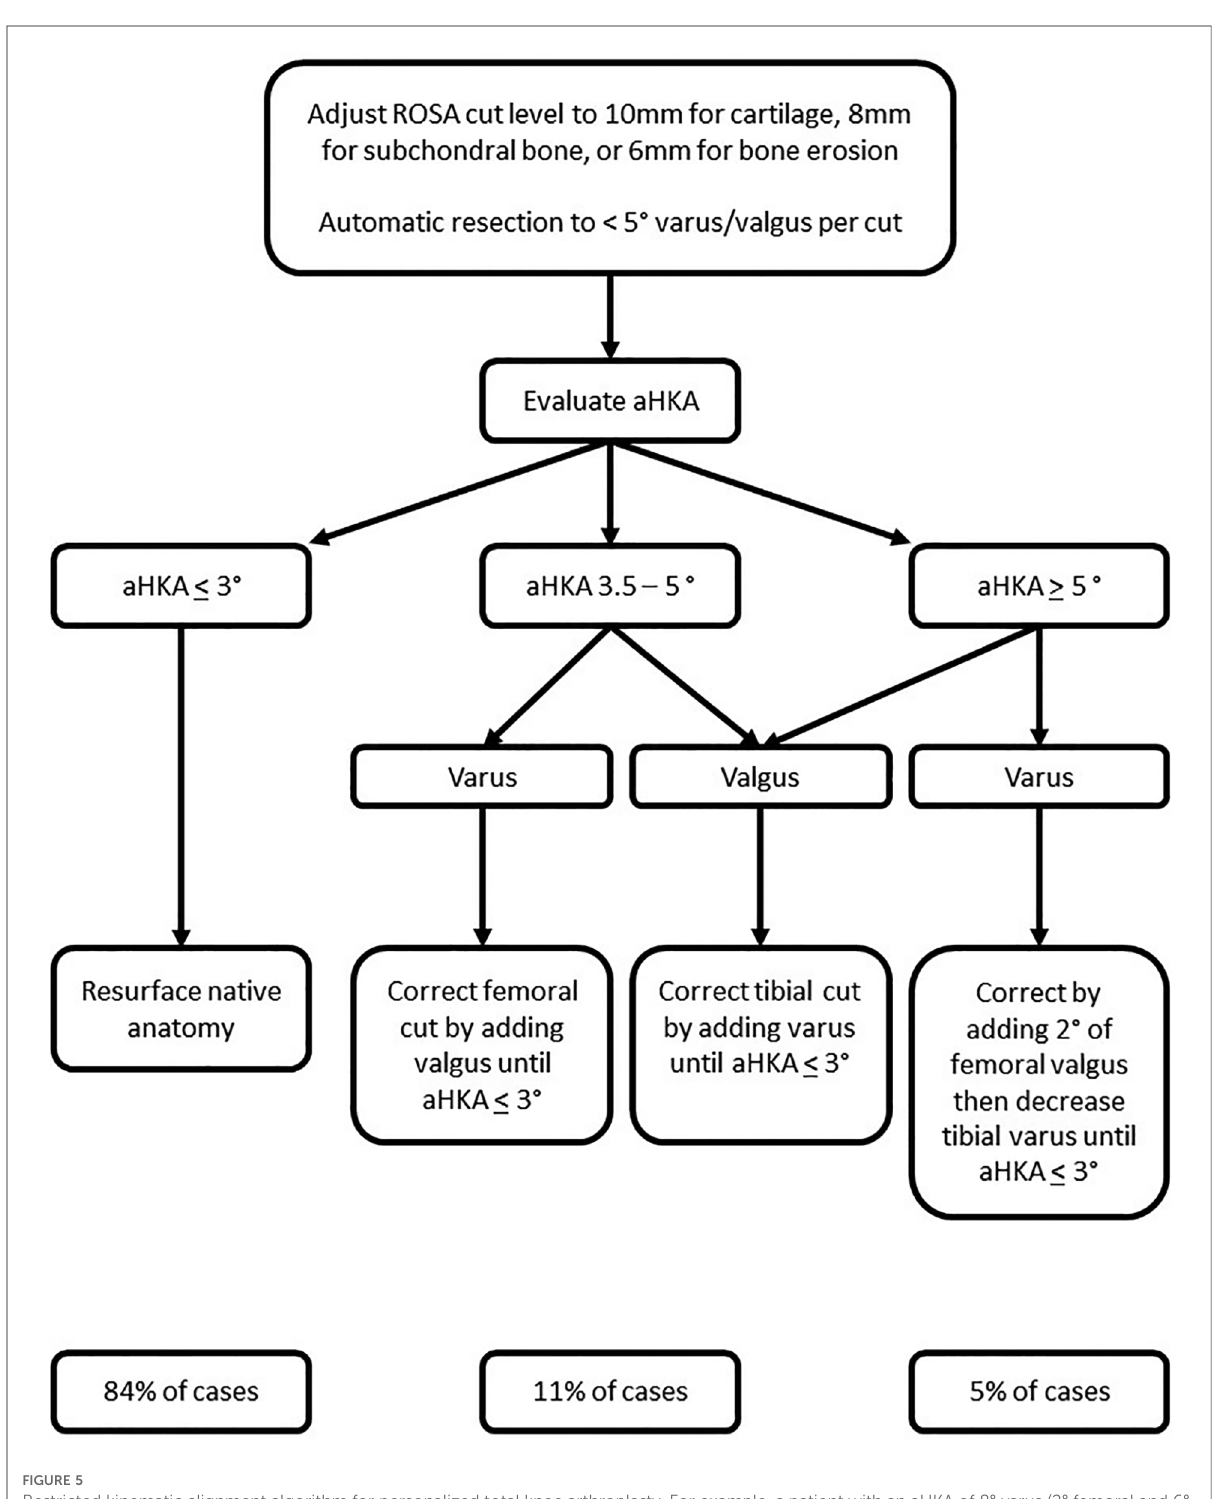
FIGURE 5 Restricted kinematic alignment algorithm for personalized total knee arthroplasty. For example, a patient with an aHKA of 8° varus (2° femoral and 6° tibial varus) we will fi rst modify the tibia to 5°. Next, we will reduce the femoral angle by 2° to 0°. Finally, we reduce the tibial angle to 3° to produce an aHKA of 3° varus. With a valgus knee, the femur is often the main contributor and will be adjusted fi rst. For example, a patient with and aHKA of 9° valgus (8° femoral and 1° tibial valgus) we would fi rst modify the femur to 5° producing a valgus aHKA of 6°. We will then modify the tibia by 3°, bringing it to 2° of varus, thus producing an aHKA of 3°